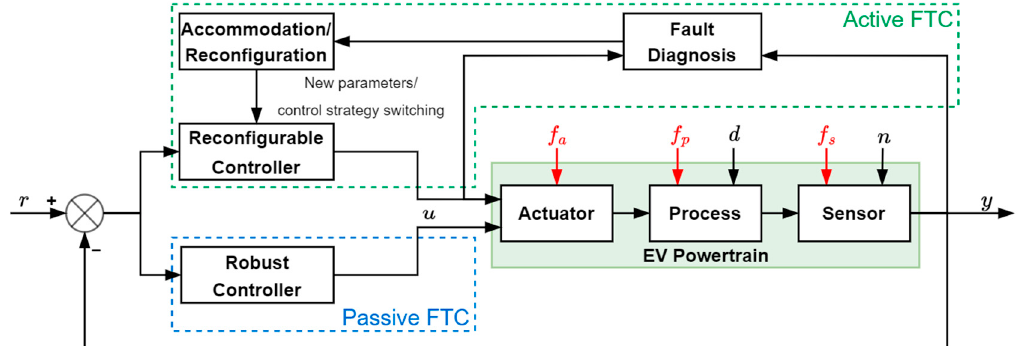
Figure 7. The architecture of active and passive fault-tolerant control strategies.